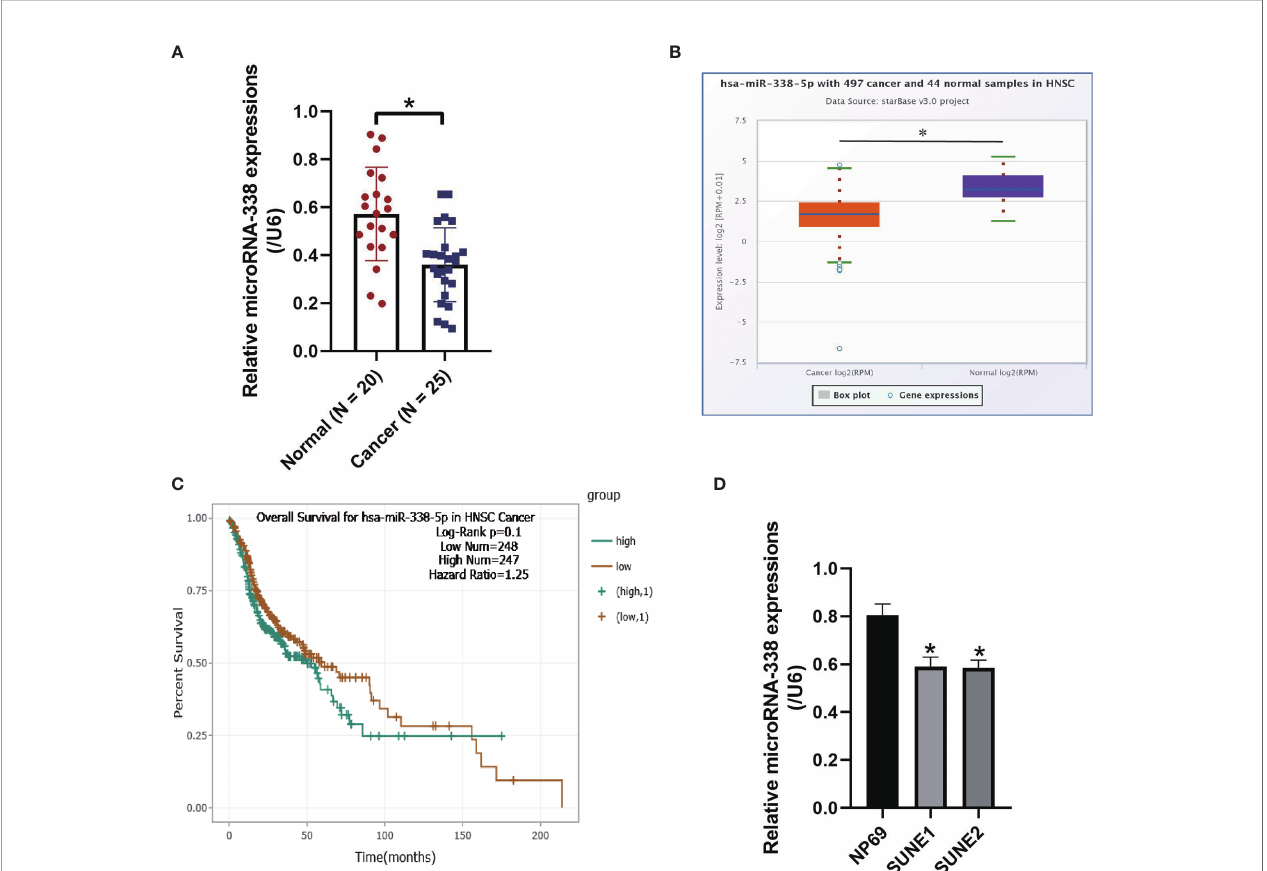
FIGURE 1 | The expression status of microRNA-338-5p were examined in the NPC clinical tissues and cell lines. (A) The NPC tissues (N = 25) and non-tumor nasopharyngeal mucosa tissues (N = 20) were obtained, and Real-Time qPCR was conducted to examine the expression levels of microRNA-338-5p. (B) The expression levels of microRNA-338-5p in the clinical tissues collected from neck squamous cell carcinoma (HNSC) were analyzed by using the online Pan-cancer analysis. (C) Pan-cancer analysis was performed to analyze the correlations of microRNA-338-5p levels and patients ’ prognosis in HNSC. (D) Real-Time qPCR was used to examine the levels of microRNA-338-5p in NPC cells. Each experiment repeated at least three times, and * P <